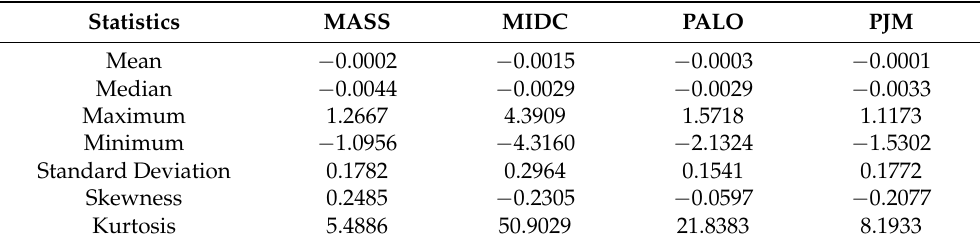
Table 2. Descriptive